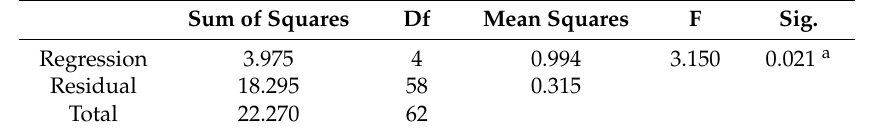
Table 12. The regression analysis of the factors on the overall value evaluation by urban designers. Sum of Squares Df Mean Squares F Sig. Regression 3.975 4 0.994 3.150 0.021 a Residual 18.295 58 0.315 Total 22.270